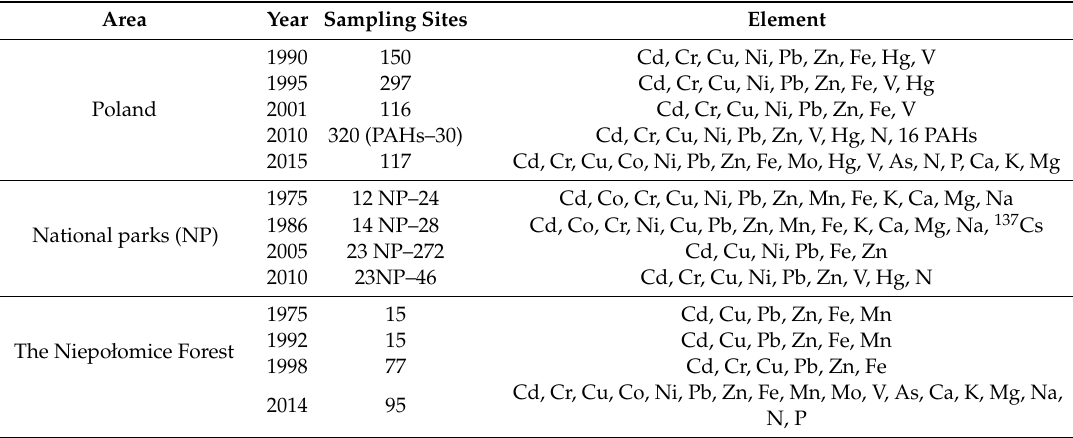
Table 1. Sampling scheme for Pleurozium schreberi in Poland (area, years and number of sampling sites) and a range of performed chemical